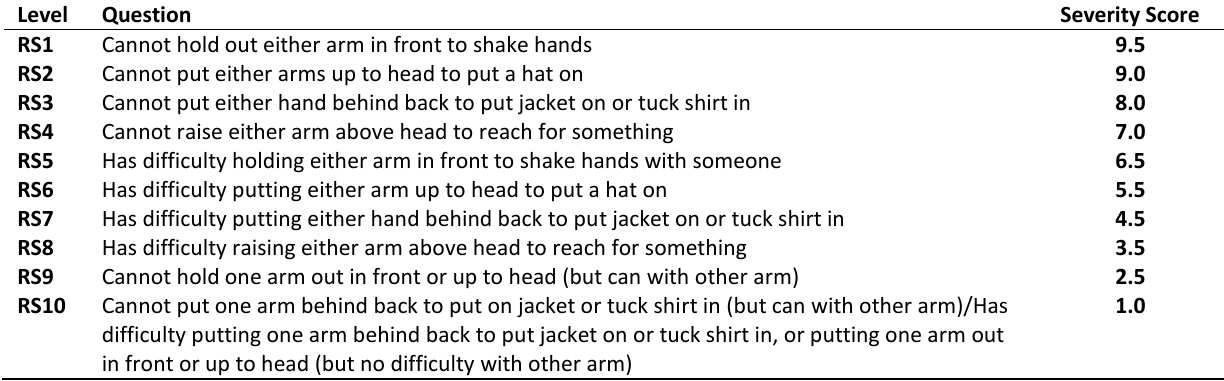
Table 3. Different levels of reaching and stretching ability, and respective severity scores. Sources: Grundy et al. (1999) and Martin et al. (1988).